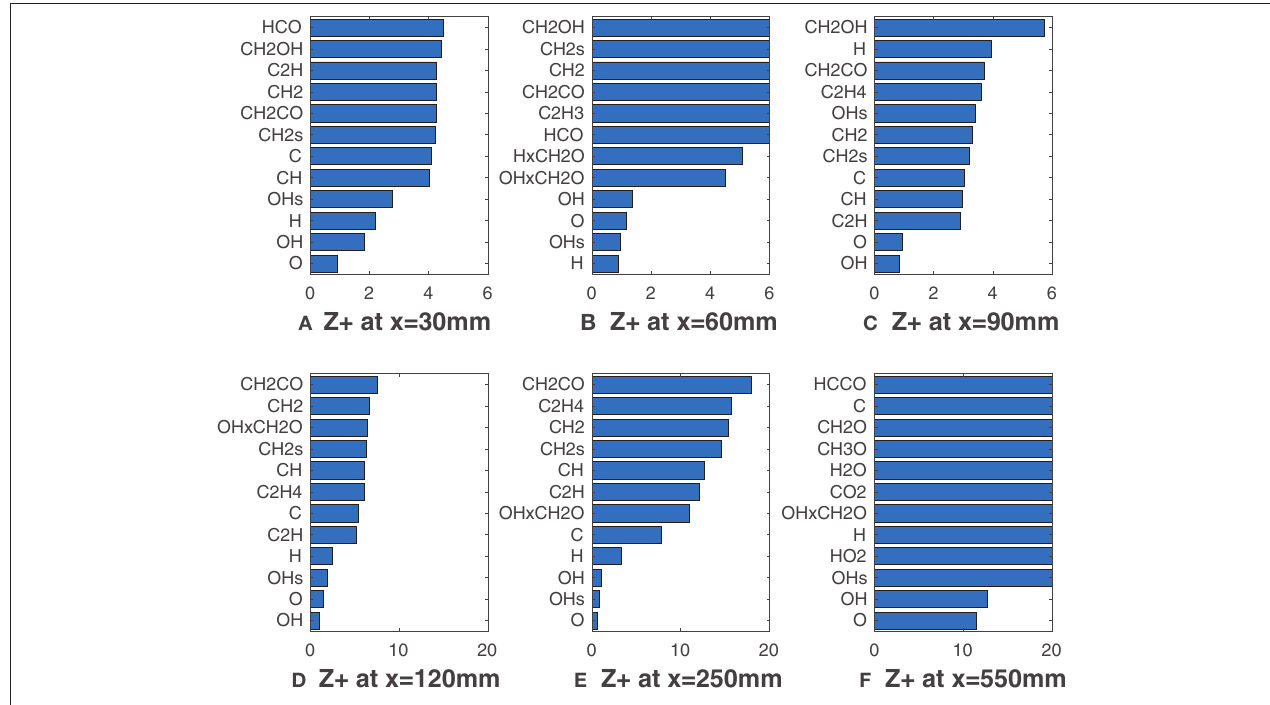
FIGURE 3 | HM1 case: best correlated species at various axial locations. Lower Z + s ( X α ) values mean better correlation.